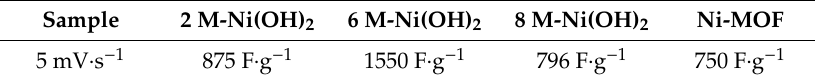
Table 2. Specific capacitance of the samples at the same scanning rate of 5 mV · s − 1.